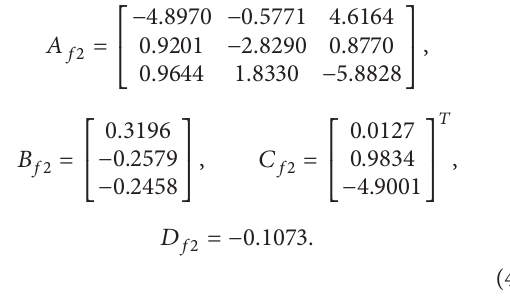
Figure 6: Response of the state 𝑥(𝑡) when 𝑤(𝑡) = 0 .